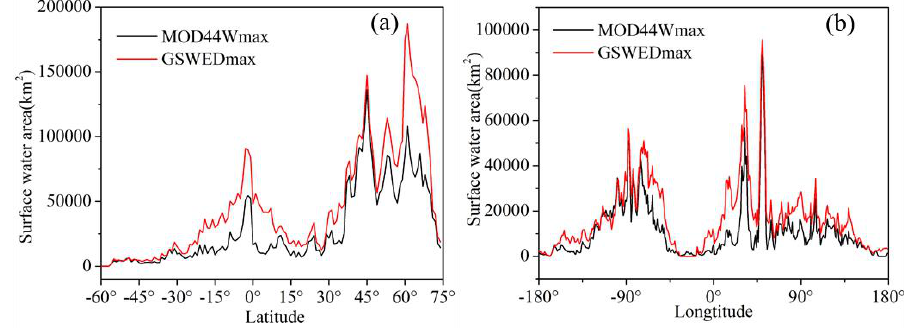
Figure 6. Latitudinal ( a ) and longitudinal ( b ) maximum area comparison for global surface water extent dataset and MOD44W between 2000 and 2015.